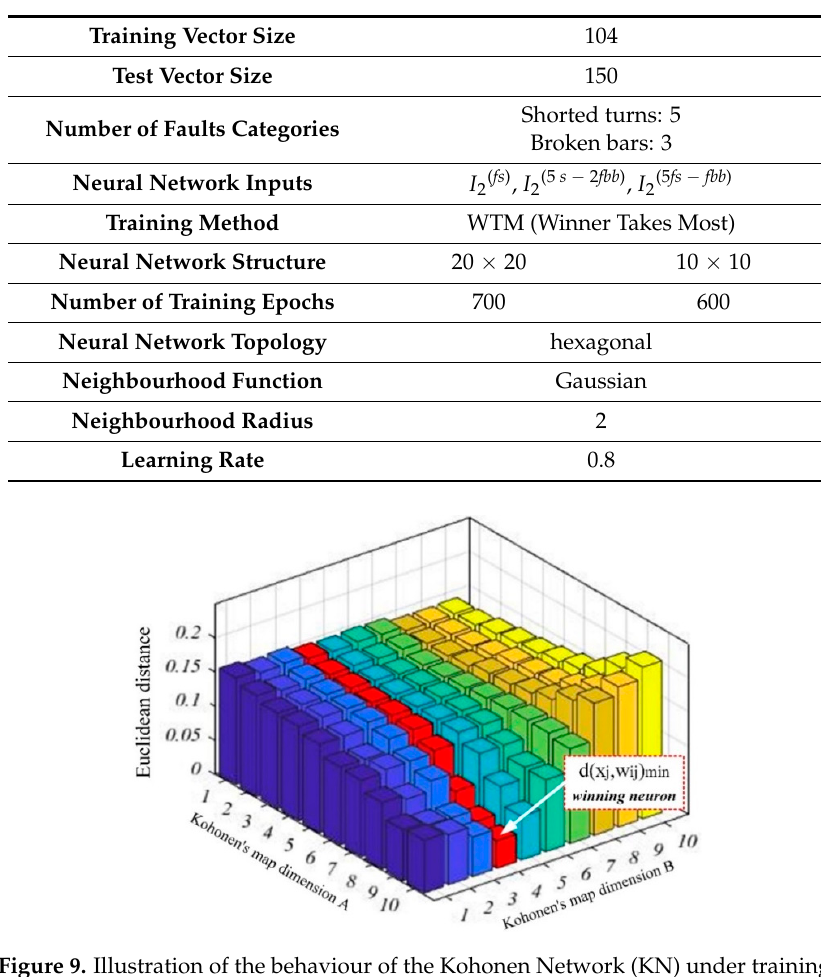
(b) Figure 11. Influence of the number of training epochs to the SOM neighbourhood distances: ( a ) 600 training epochs; ( b ) 200 training epochs. Based on the analysis of the network response to the learning and test data vectors, the number of learning epochs was selected. In the case of a 20 × 20 network, the number of training epochs was 700, while for networks with a size of 10 × 10, 600 epochs. The results obtained for the bigger network were comparable with a 10 × 10 map, thus the results obtained with this less complicated map were shown in the next section. The response of the designed network to the given training vector allowed to highlight the Kohonen map zones characteristic of specific IM damage categories. 5.2. Results of Stator and Rotor Fault Classification The experimental verification of the obtained networks was carried out for the classification of rotor and stator winding failures and for mixed damage. In addition, the effect of the no-load machine’s operation on the fault classification process of the broken rotor bars was checked. On the